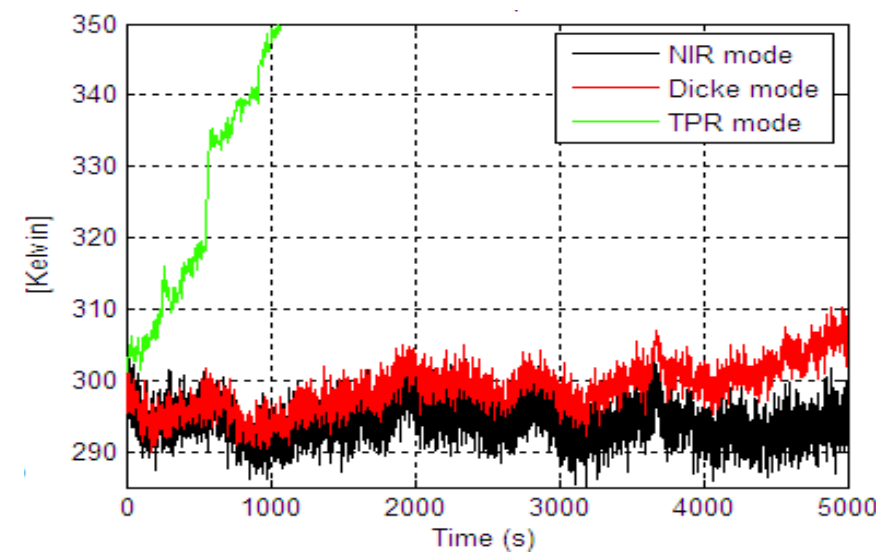
Figure 6. The measured antenna temperature for the three modes of operation of the K-band